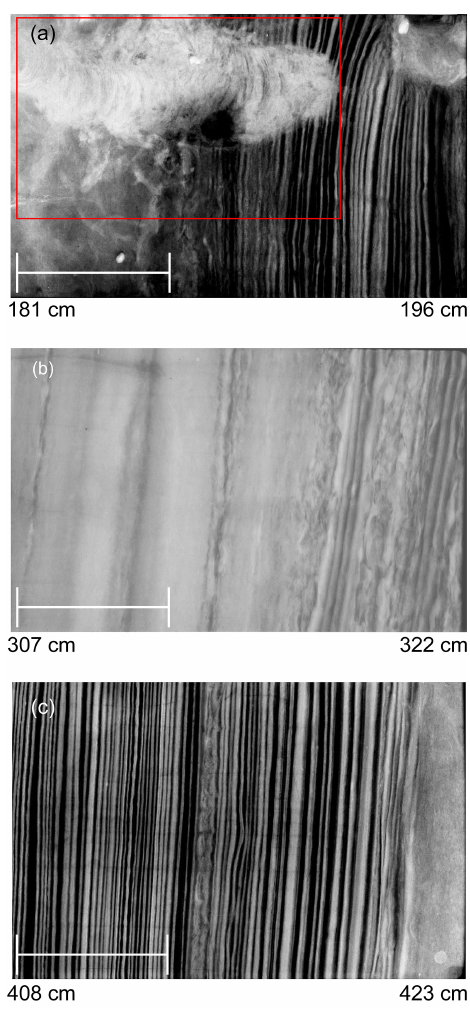
Figure 3. Examples of three different sediment facies in SO202-18-3/6 as shown in radiographs. (a) Bioturbated Facies (left side) and Bioturbated Lamination Facies (middle section) at the end of Preboreal laminations, (b) Layered Facies, and (c) Laminated Fa- cies during the Preboreal. All radiographs are shown with increas- ing core depth to the right. The core depths of each radiograph sec- tions are indicated below the images. The red box in (a) marks a bioturbational feature that led to an age reversal in a 14 C age in core SO202-18-6, 180–182.5cm. The scale bar on each radiograph marks a 5cm